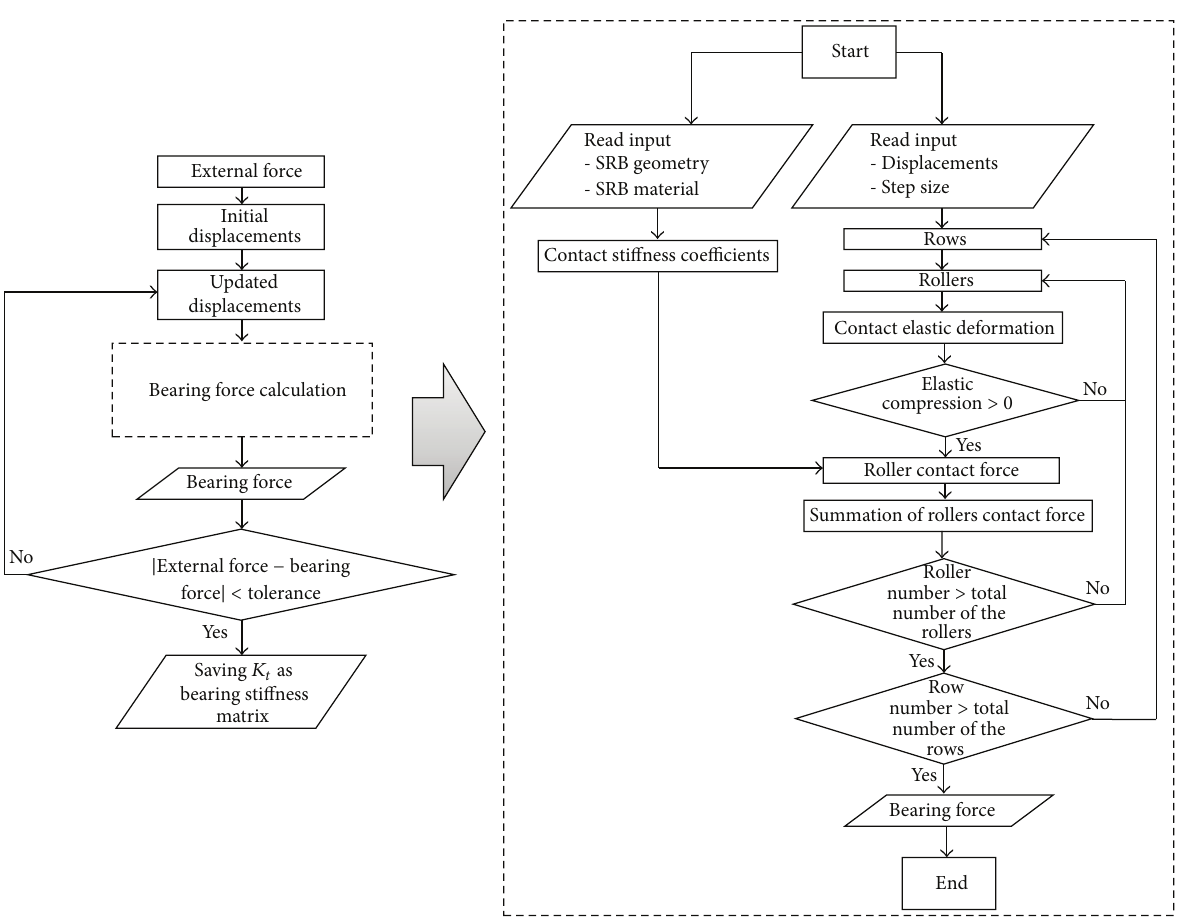
Figure 1: Block diagram for the bearing stiffness matrix and bearing force